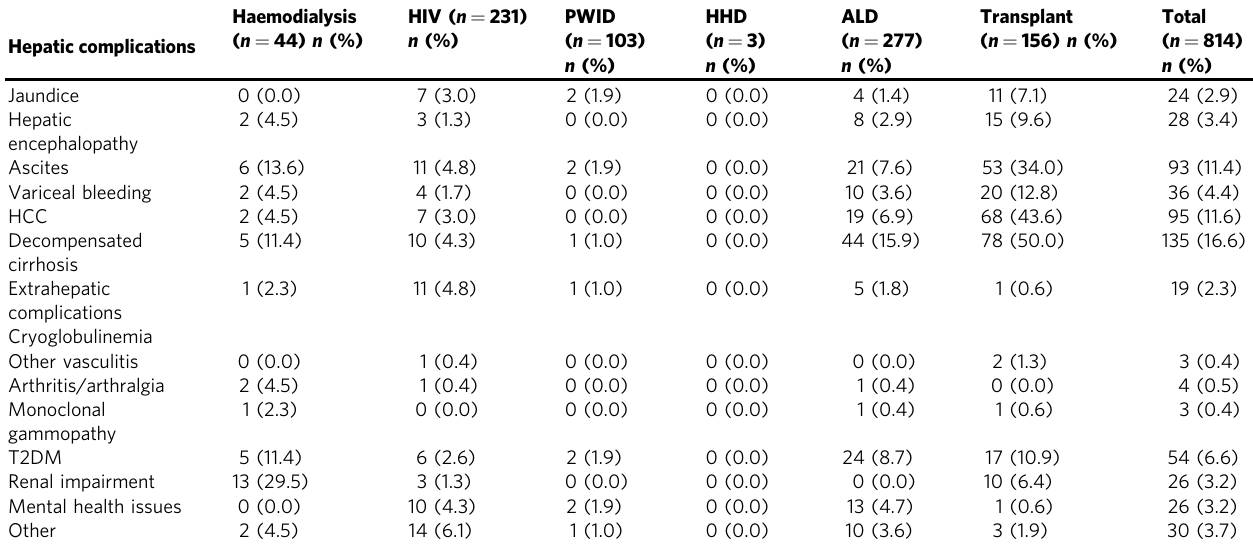
Table 4 Analysis of hepatic and extrahepatic complications of patients treated for